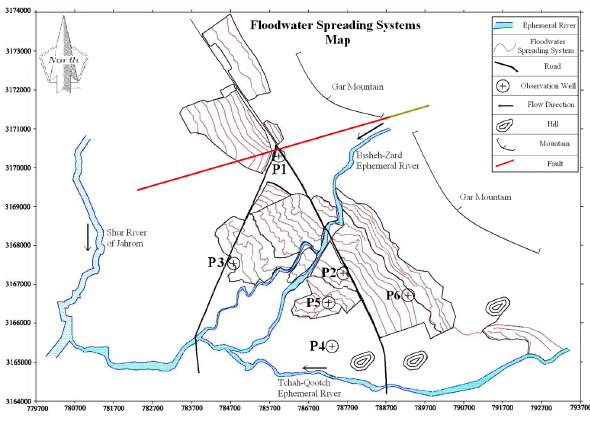
Fig. 2. Floodwater spreading system, river network, and observation well distribution in the Gareh-Bygone Plain.